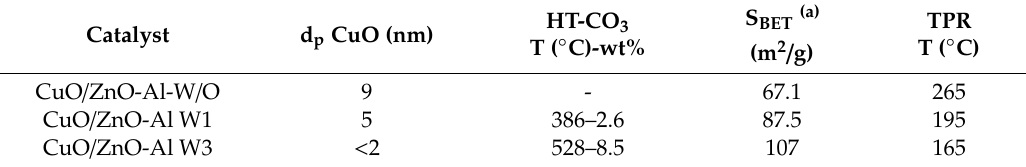
Table 2. CuO crystallite size (XRD), carbonate retention (thermogravimetric analysis (TGA)), surface area and reduction temperature (from temperature programmed reduction, TPR) of calcined